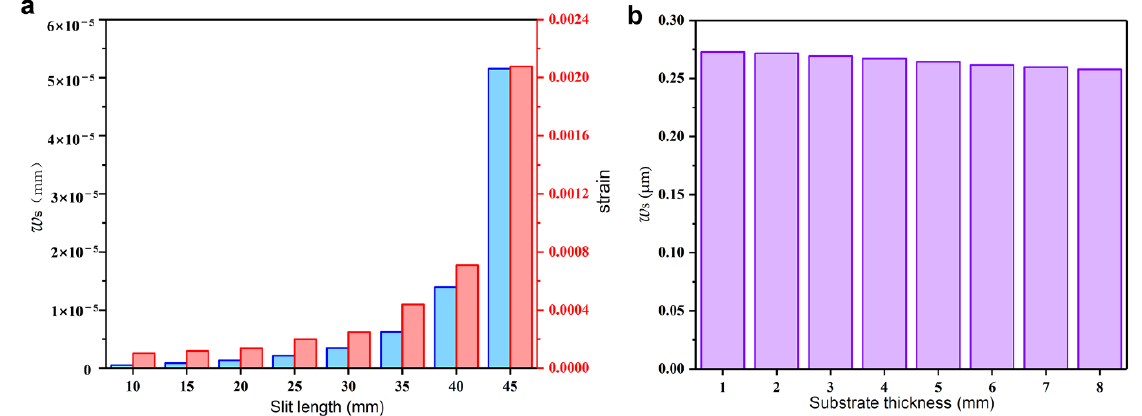
Figure 7. Simulation analysis of the influence of slit length and substrate thickness on the slit-wake deformation. ( a ) The slit-wake deformation and stress concentration on the slit tip with different slit lengths. ( b ) The influence of substrate thickness on the slit-wake deformation.